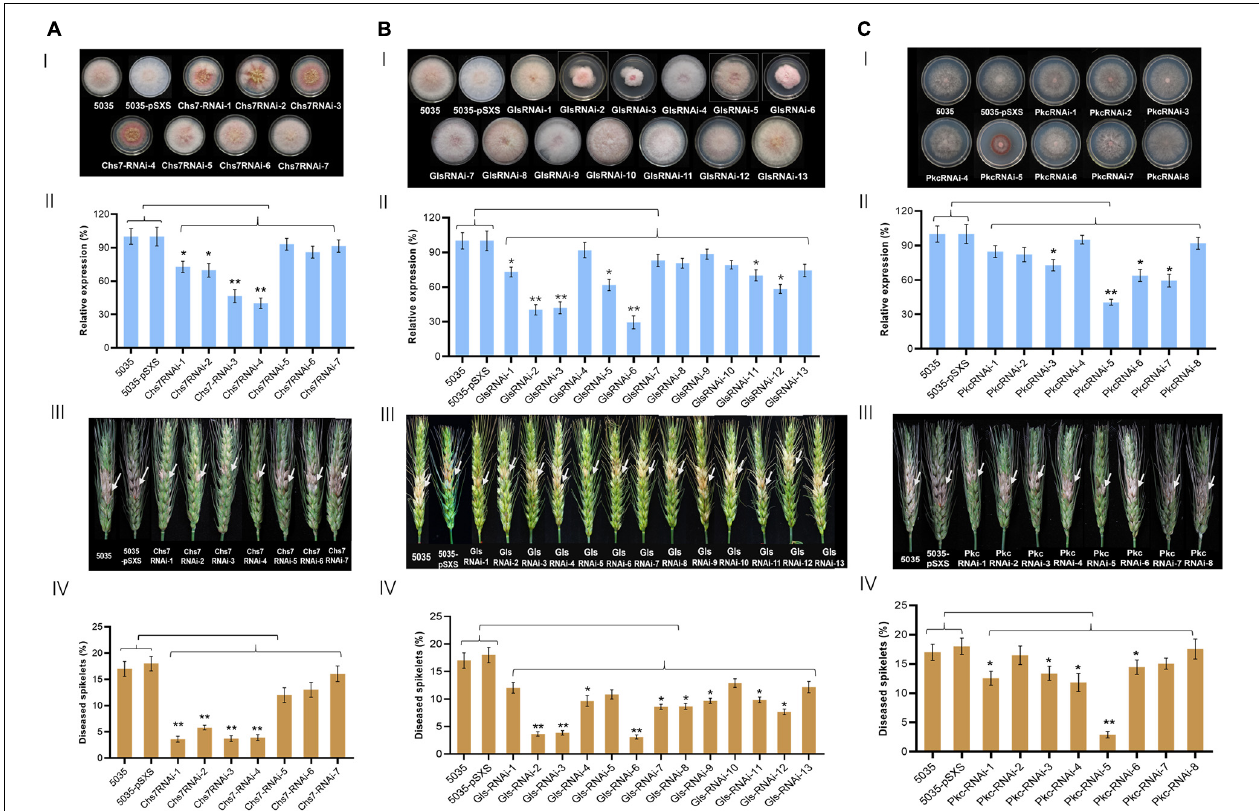
FIGURE 2 | Mycelium growth, relative expression of target genes and pathogenicity of Fg strains transformed with RNAi constructs derived from Chs7 (A) , Gls (B) , and Pkc (C) . I , Mycelium growth of Fusarium graminearum (Fg) strains on PDA at 22 ◦ C for 4 days. II , Relative expression levels of Chs7 , Pkc , and Gls genes in the Fg strains shown in I . The expression levels were normalized to the levels of the fungal β -tubulin gene. III , Phenotypes of wheat spikes at 21 dai with Fg strains shown in I . IV , Percentages of infected wheat spikelets at 21 dai. The bars represent mean values standard error of three independent biological experiments II and 20 wheat spikes III . Asterisks represent a statistically significant difference (* P < 0.05 and ** P < 0.01), according to Student’s t -tests.